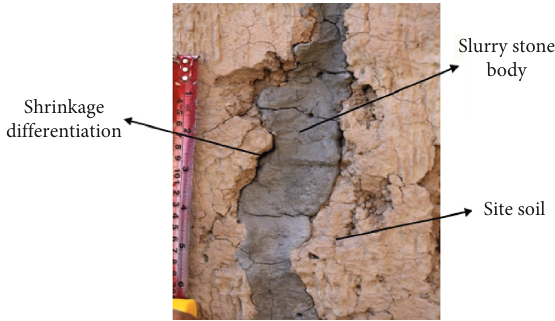
Figure 10: Macroscopic morphology of fissures after conventional slurry and grouting